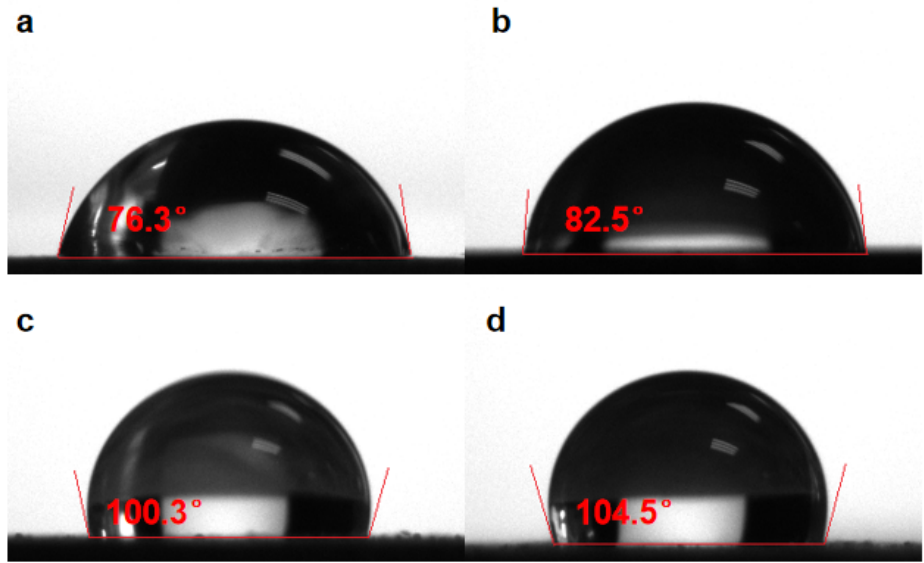
Figure 6. Contact angle of di ff erent interfaces: ( a ) 316SS, ( b ) pPy/C, ( c ) CNNS/PMMA/pPy/C, and